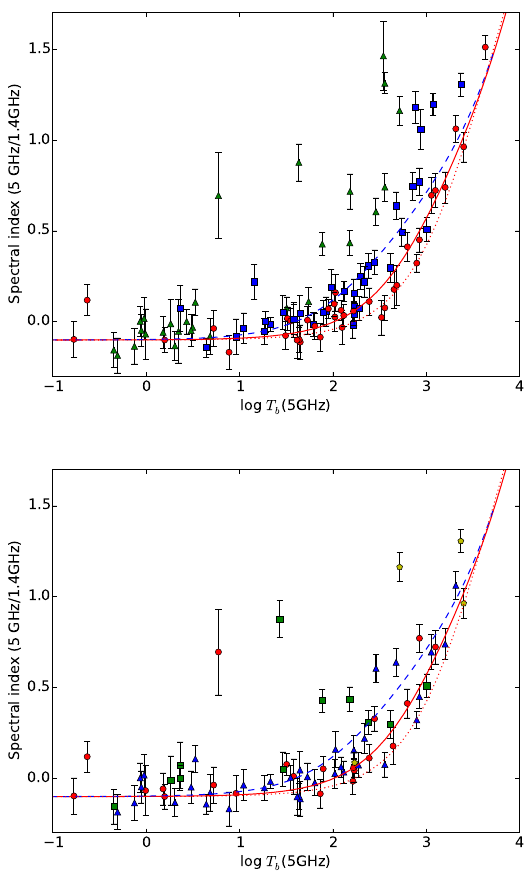
Figure 2. The 5 GHz to 1.4 GHz spectral index as a function of brightness temperature at 5 GHz. The solid red line and blue dashed line denote a PES model with a / b = 3 and t / b = 0.1 and t / b = 0.01, respectively. The dotted line marks the spherical model. In the top figure, PNe are split into three groups with respect to the η parameter: η < 0.5 (red circles), 0.5 < η < 0.9 (blue squares), and η > 0.9 (green triangles). In the bottom figure, PNe are split according to morphological type: spherical (red circles), elliptical (blue triangles), bipolar (green squares), and multipolar PNe (yellow pentagons)